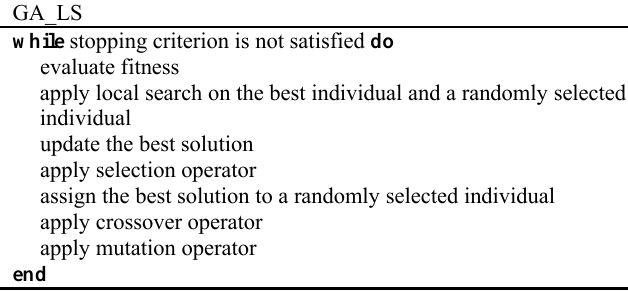
Fig. 4. The procedure of